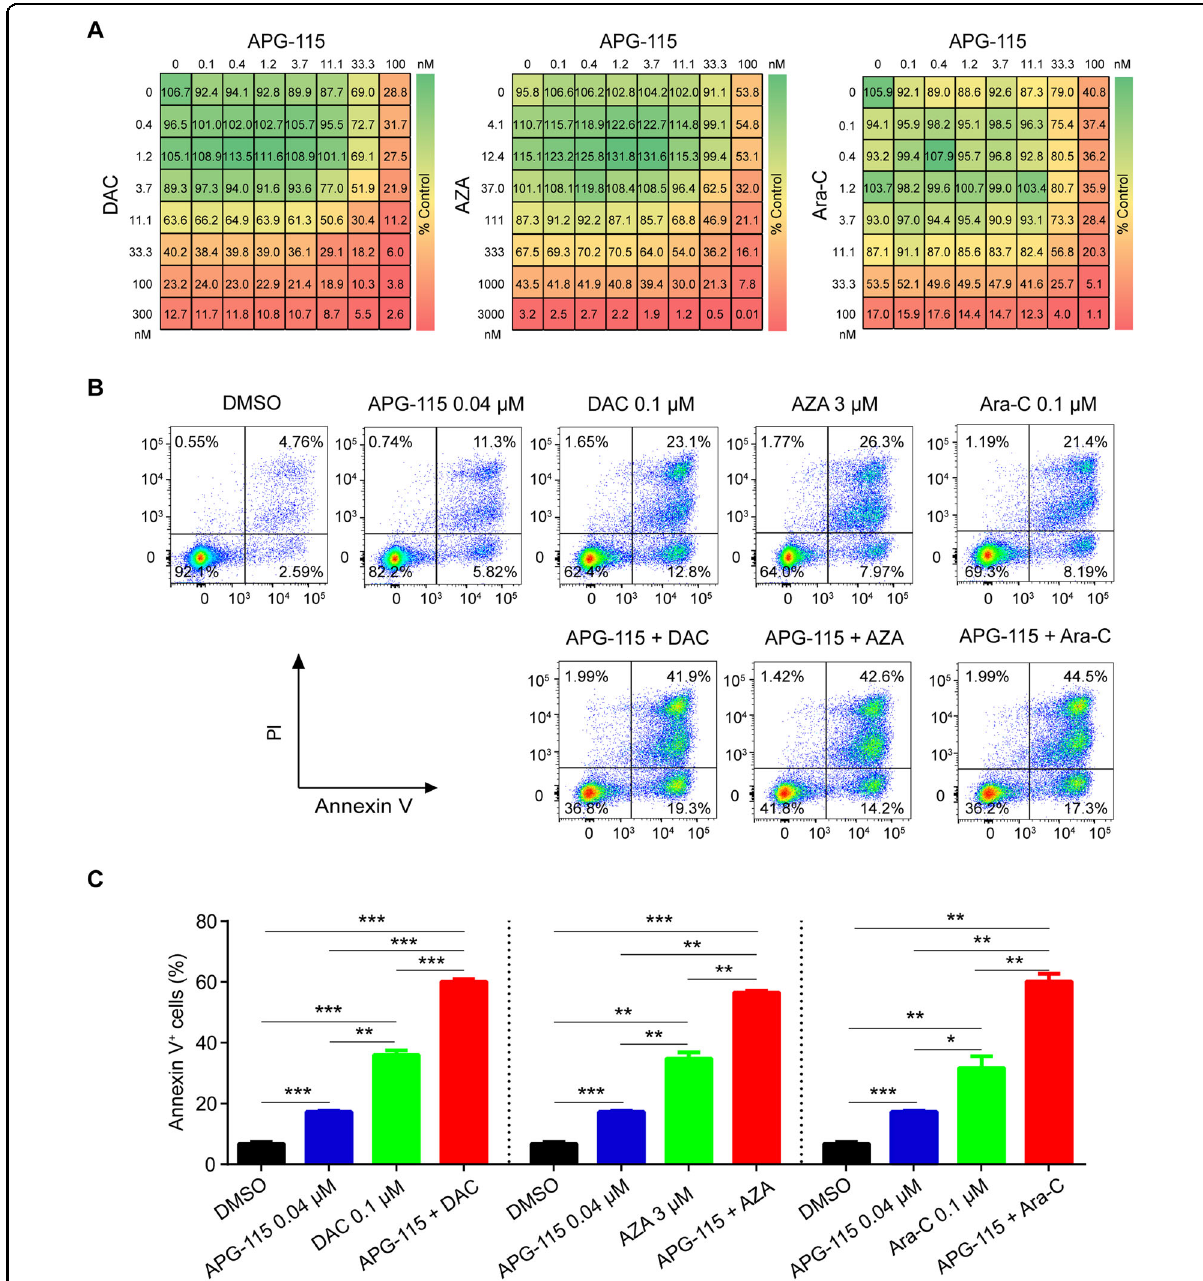
Fig. 3 APG-115 synergizes with AZA, DAC, and Ara-C to inhibit cellular growth and induce apoptosis in TP53 wt AML cells. A Drug dose matrix of human MOLM-13 cells treated with increasing concentrations of APG-115, AZA, DAC, Ara-C or their combinations for 72 h. Cell viability was assessed using the CellTiter-Glo ® assay. Representative results from three independent experiments are presented. The drug dose matrix indicates the percentage of cell viability of treated cells relative to vehicle controls. B Representative fl ow cytometry results from three independent experiments involving MOLM-13 cells treated with indicated concentrations of APG-115, DAC, AZA, and Ara-C (alone or in combination) for 48 h show enhanced apoptogenic effects. C Mean (SD) proportions of apoptotic cells ( n = 3 replicates) show signi fi cant increases in cell lines exposed to APG-115 combined with SOC agents (vs. either alone). * p < 0.05, ** p < 0.01, *** p < 0.001 by one-way ANOVA tests for data from three independently repeated experiments. DMSO, dimethylsulfoxide (vehicle); PI, propidium